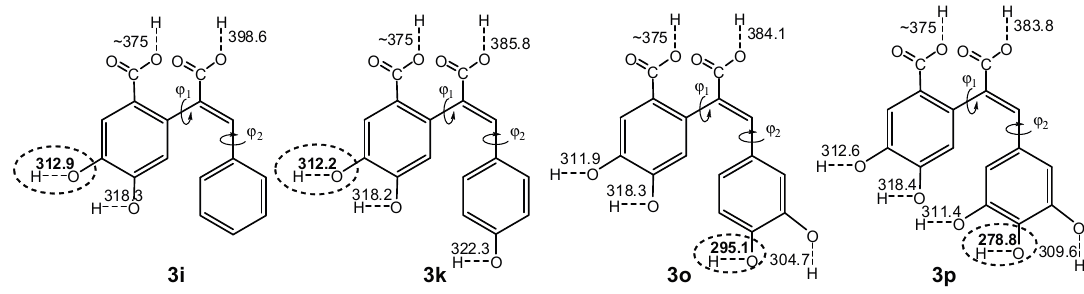
Figure 3. BDEs of compounds 3i , 3k , 3o and 3p for a homolytic dissociation of different bonds. Calculations are performed at IEF-PCM (U)B3LYP/6-31+G(d) level of theory.